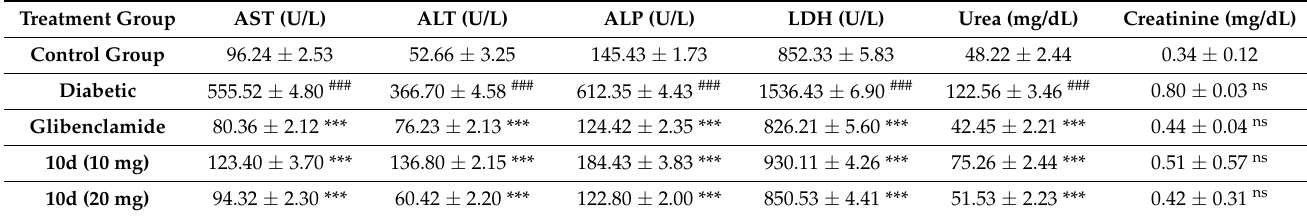
Table 4. Effect of tested compound 10d on liver and renal serum